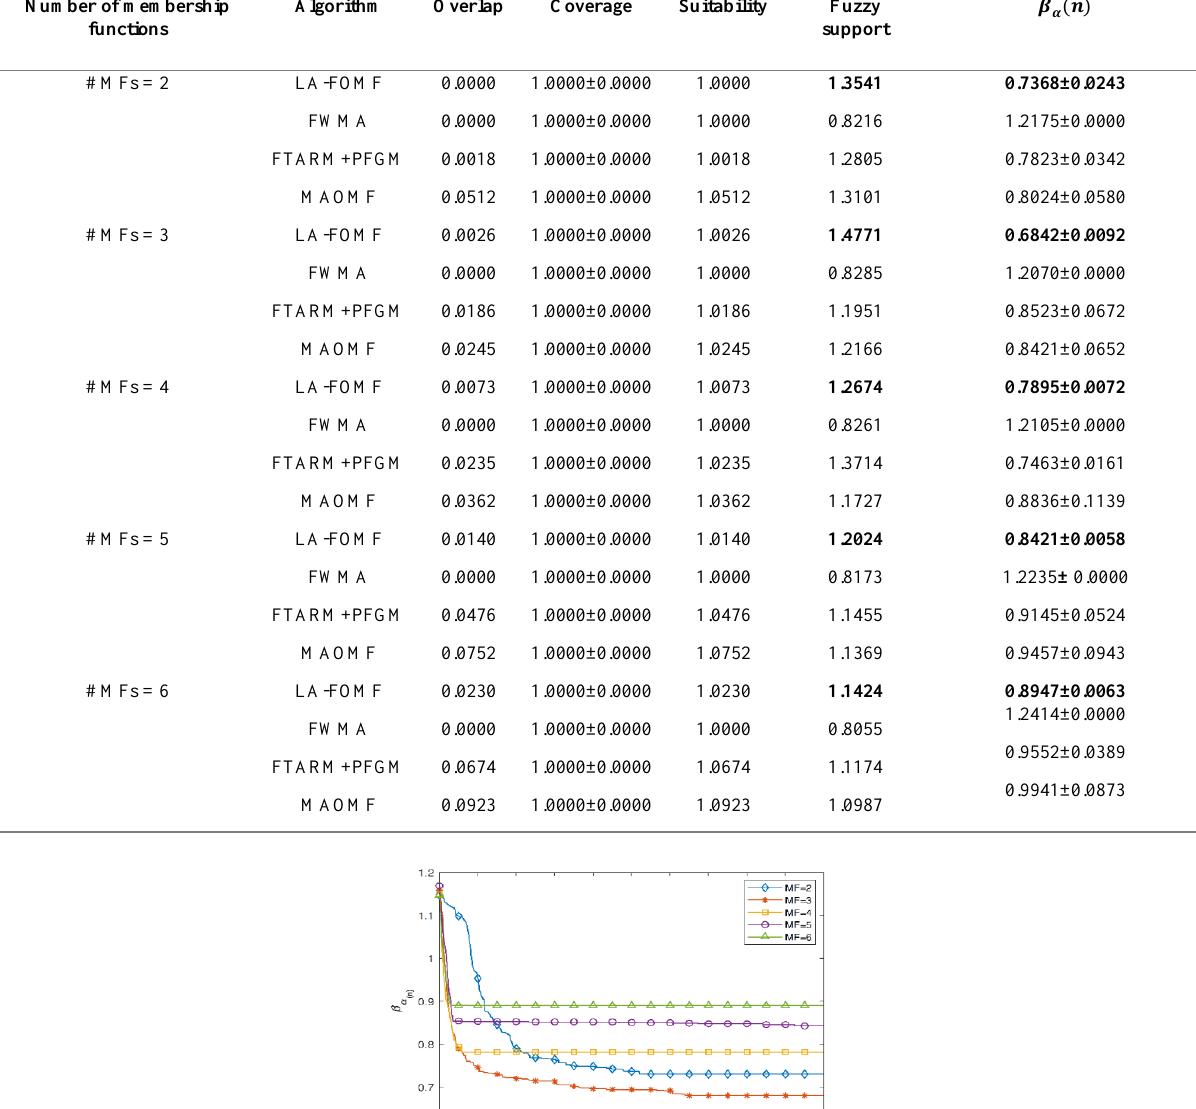
Table 6 . Comparison of the results between LA-OMF and other algorithms.